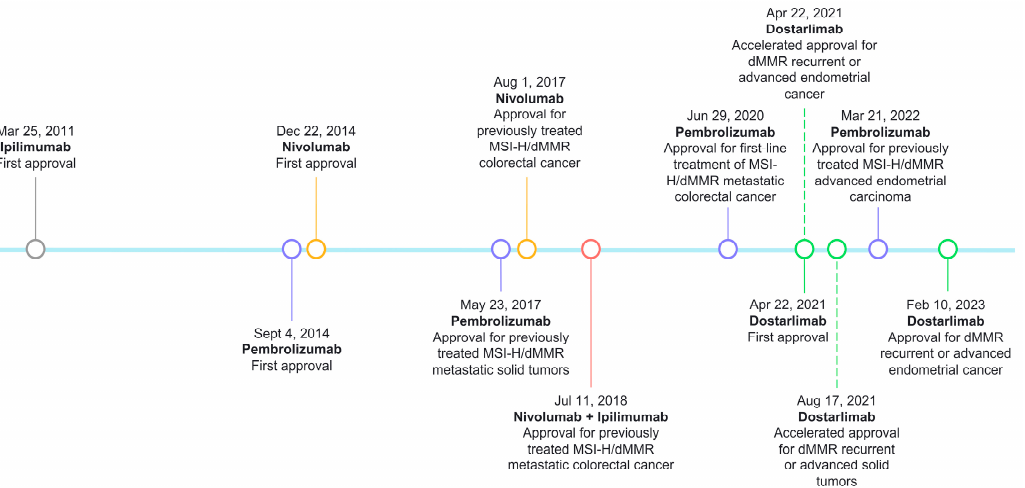
Figure 3. FDA approval timeline of immune checkpoint inhibitors for MSI/dMMR tumors.